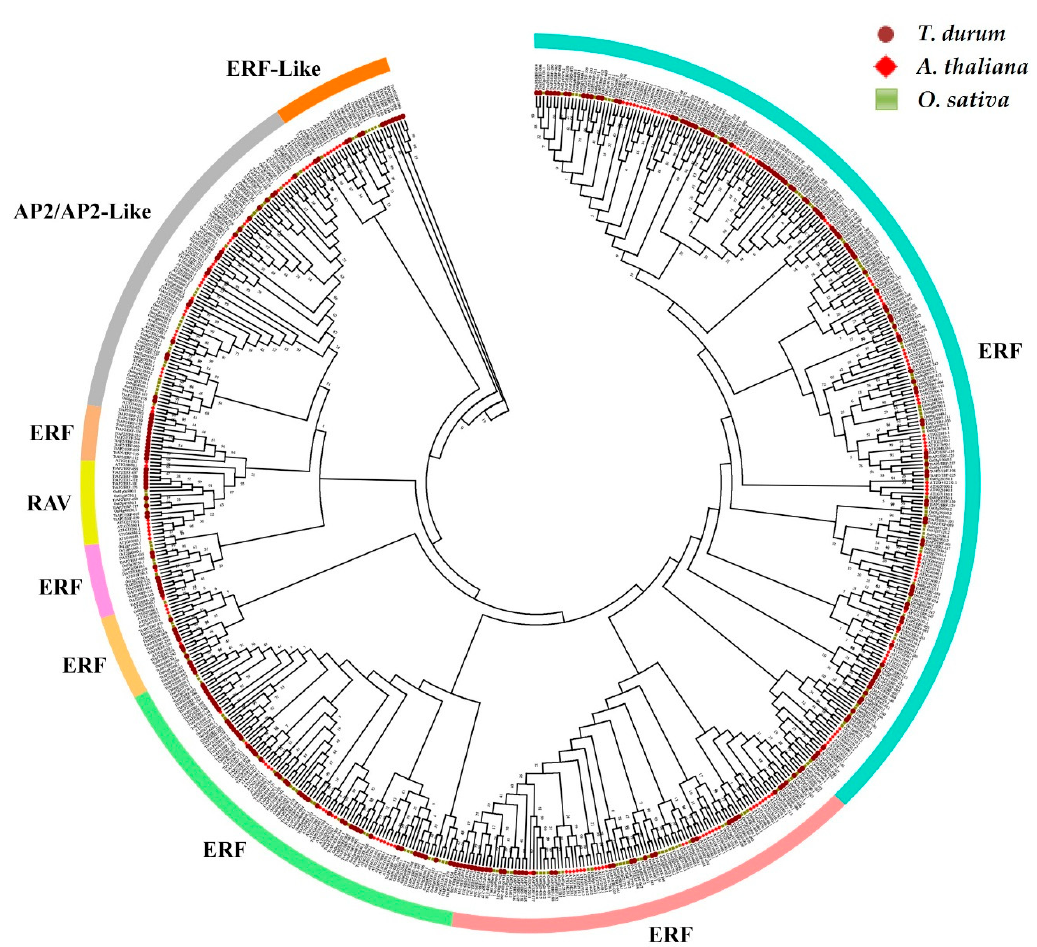
Figure 4. Phylogenetic analysis of AP2 / ERF proteins from durum wheat, rice, and Arabidopsis using MEGA 6 software based on the NJ method.